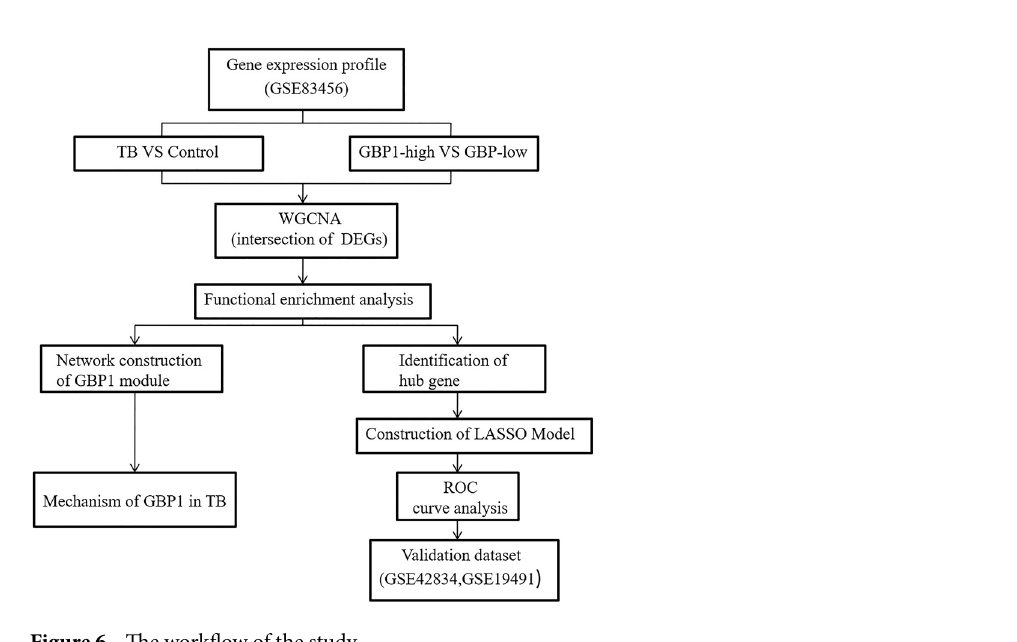
Figure 6. The workflow of the